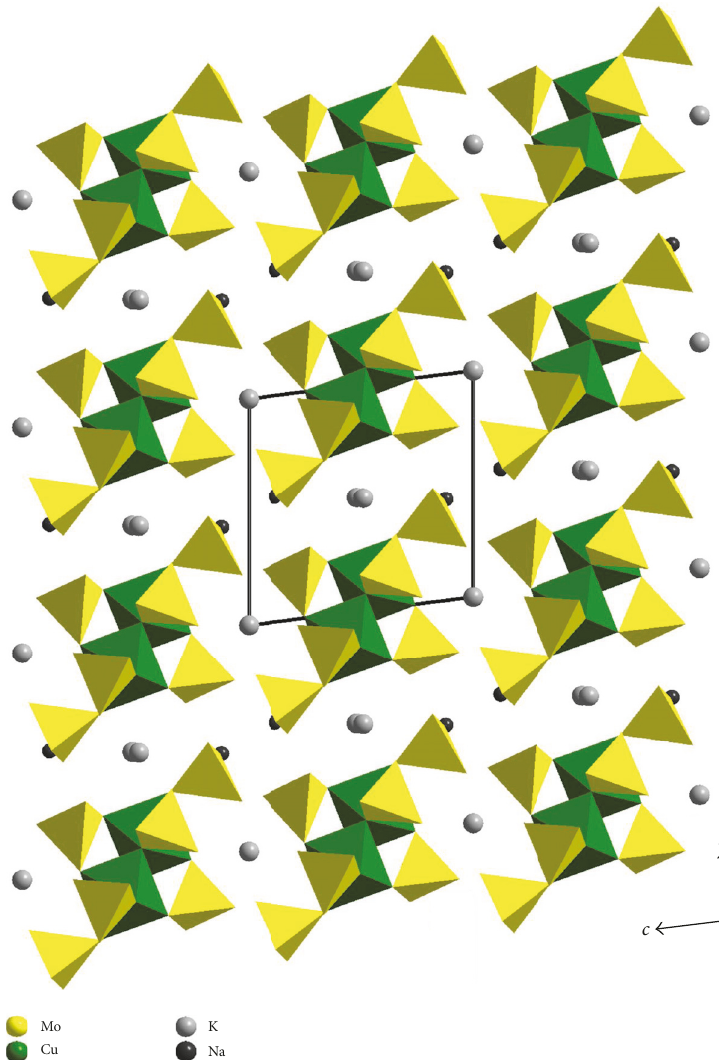
Figure 2: Projection of Na 2 K 2 Cu(MoO 4 ) 3 structure according to 𝑎